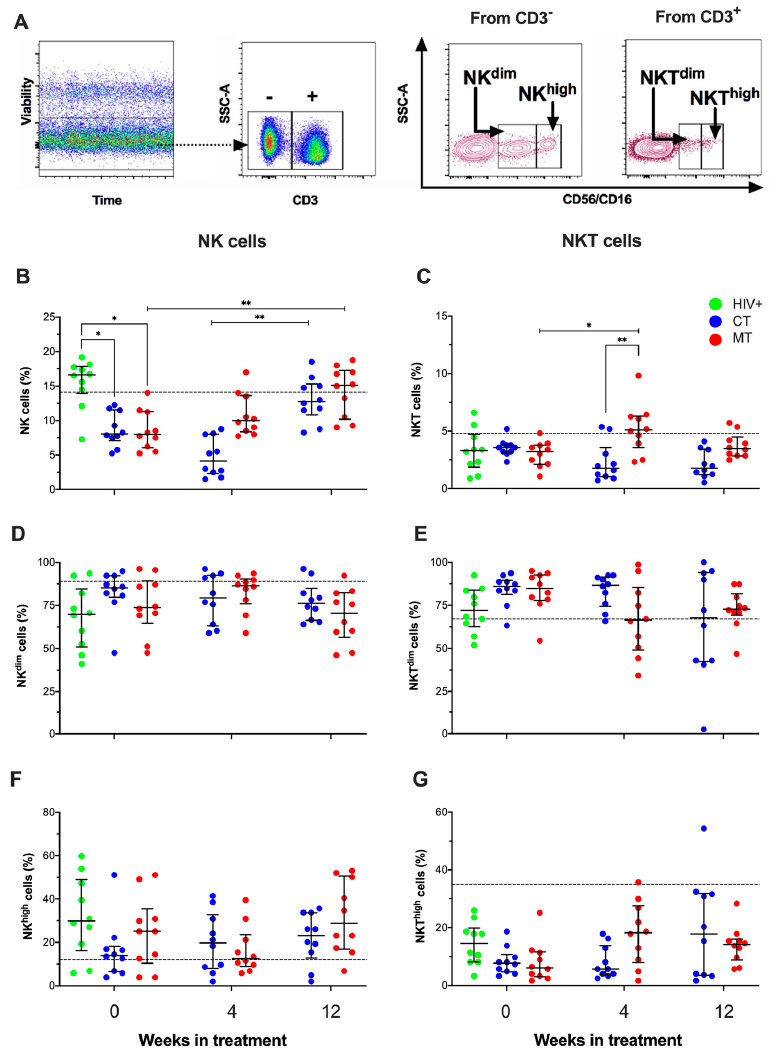
Figure 5. The frequency of NK cells decreased with the KSHV infection and increased after treat- ment with either scheme treatment. Singlets cells were identified through forward scatter (FSC-A versus FSC-H). Then, viable cells were selected, followed by forward scatter (FSC) and side scatter (SSC) dot plot to selected live lymphocytes (Dot plots not displayed). ( A ) From CD3-negatives or CD3-positives events, NK or NKT (dim/high) cells based on CD56/CD16 expression were identified. The frequency of NK ( B ) and NKT ( C ) cells and their subpopulations dim ( D , E ) and high ( F , G ) in HIV+ asymptomatic men and KS/HIV patients were analyzed as indicated. The black dashed line represents the median value of HIV-negative men. Green dots represent HIV+ asymptomatic men, blue dots represent CT and red MT participants. Statistical comparisons were performed using Kruskal–Wallis test, * p < 0.05, ** p < 0.01.